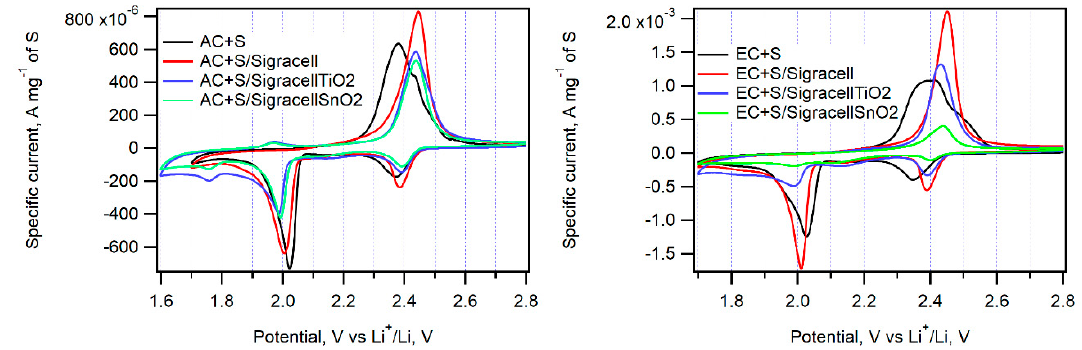
Figure 7. Cyclic voltammograms of the EC + TiO 2 + S, AC + TiO 2 + S and MP + TiO 2 + S samples recorded with a scan rate of 0.1 mV s − 1 .